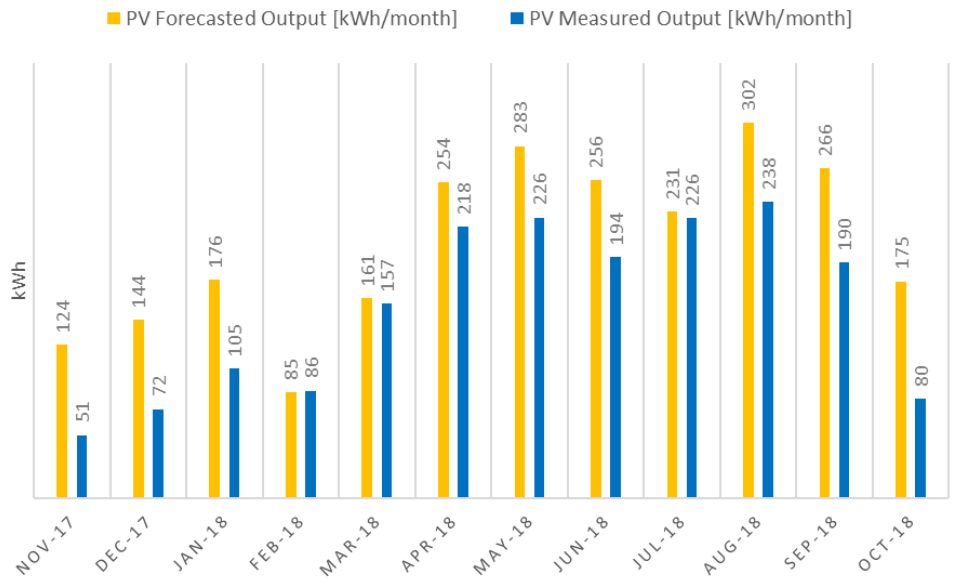
Figure 5. Comparison between measured and modeled PV energy output.